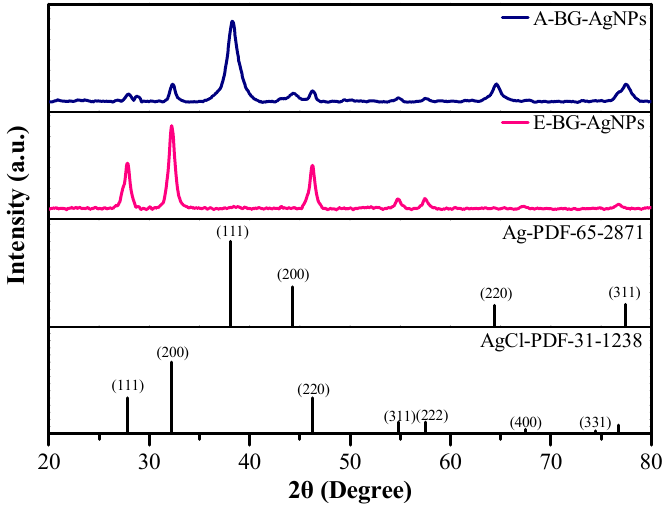
Figure 3. X-ray diffraction pattern of A- and E-BG-AgNPs. The elemental composition and oxidation state of BG-mediated AgNPs were studied using X-ray photoelectron spectroscopy (XPS). The full-scan spectrum of A-BG-AgNPs and E-BG-AgNPs, along with the analysis of the detailed elements of carbon (C1s), oxygen (O1s), and silver (Ag3d), are presented in Figure 4. In Figure 4b, the high-resolution Ag3d spectrum of A-BG-AgNPs corresponds to Ag3d 3/2 and Ag3d 5/2 , with binding energies (BEs) at 368.1 and 374.1 eV. Both signals can be further fitted to several symmetrical peaks with BEs at 367.9 and 368.1 eV, which correspond to metallic Ag and AgCl, respectively. For the XPS analysis of C1s and O1s signals, Figure 4c reveals these peaks can be deconvoluted into C–O (285.9 eV), and C–H, or C–C (284.6 eV), whereas peaks from the O1s data (Figure 4d) are assignable to AgO (532.2 eV) and O–C=O (533.2 eV). For the E-BG-AgNPs, all of the elemental compositions were similar to that of the A-BG-AgNPs, except for the Ag element. The Ag3d spectrum of the E-BG-AgNPs (Figure 4f) showed deconvoluted peaks at 367.8 and 368.1 eV, belonging to AgCl and Ag 2 O, respectively [46]. In Figure 5a,b, the FT-IR spectra of A-BGE and E-BGE showed similar peak patterns at approximately 3425, 2943, 1637, 1386, and 1106 cm –1 , respectively, corresponding to O–H stretching (alcohol), C–H stretching (alkane), N–H bending (amines) or C=C stretching (alkene), C–H bending (aldehyde), and C–O stretching (primary alcohol) or C–N stretching (amine). In addition, E-BGE also displayed all of the peaks mentioned above, with an extra sharp peak at approximately 1780 cm –1 , detected and assigned to C=O stretching of conjugated acid halide. The functional groups present in bitter gourd extracts are in agreement with previous studies [28,29]. FT-IR data also pointed out that both the BG- AgNPs showed peak shifts with a decrease in peak intensities at approximately 3430, 2929, and 1631 cm –1 , as well as the disappearance of a few characterized peaks. The E-BG- AgNPs showed an extra intense peak at 2851 cm –1 , corresponding to N–H stretching of the amine